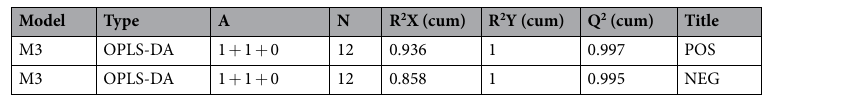
Table 1. Summary for the OPLS-DA Model-Based Discrimination between parasitized and non-parasitized (parasitized VS non-parasitized) aphids Using Cross-Validation. R 2 X and R 2 Y values indicate the total number of variations in the X and Y matrix explained by the model, respectively. Q 2 represents the predictability of the models and relates to its statistical